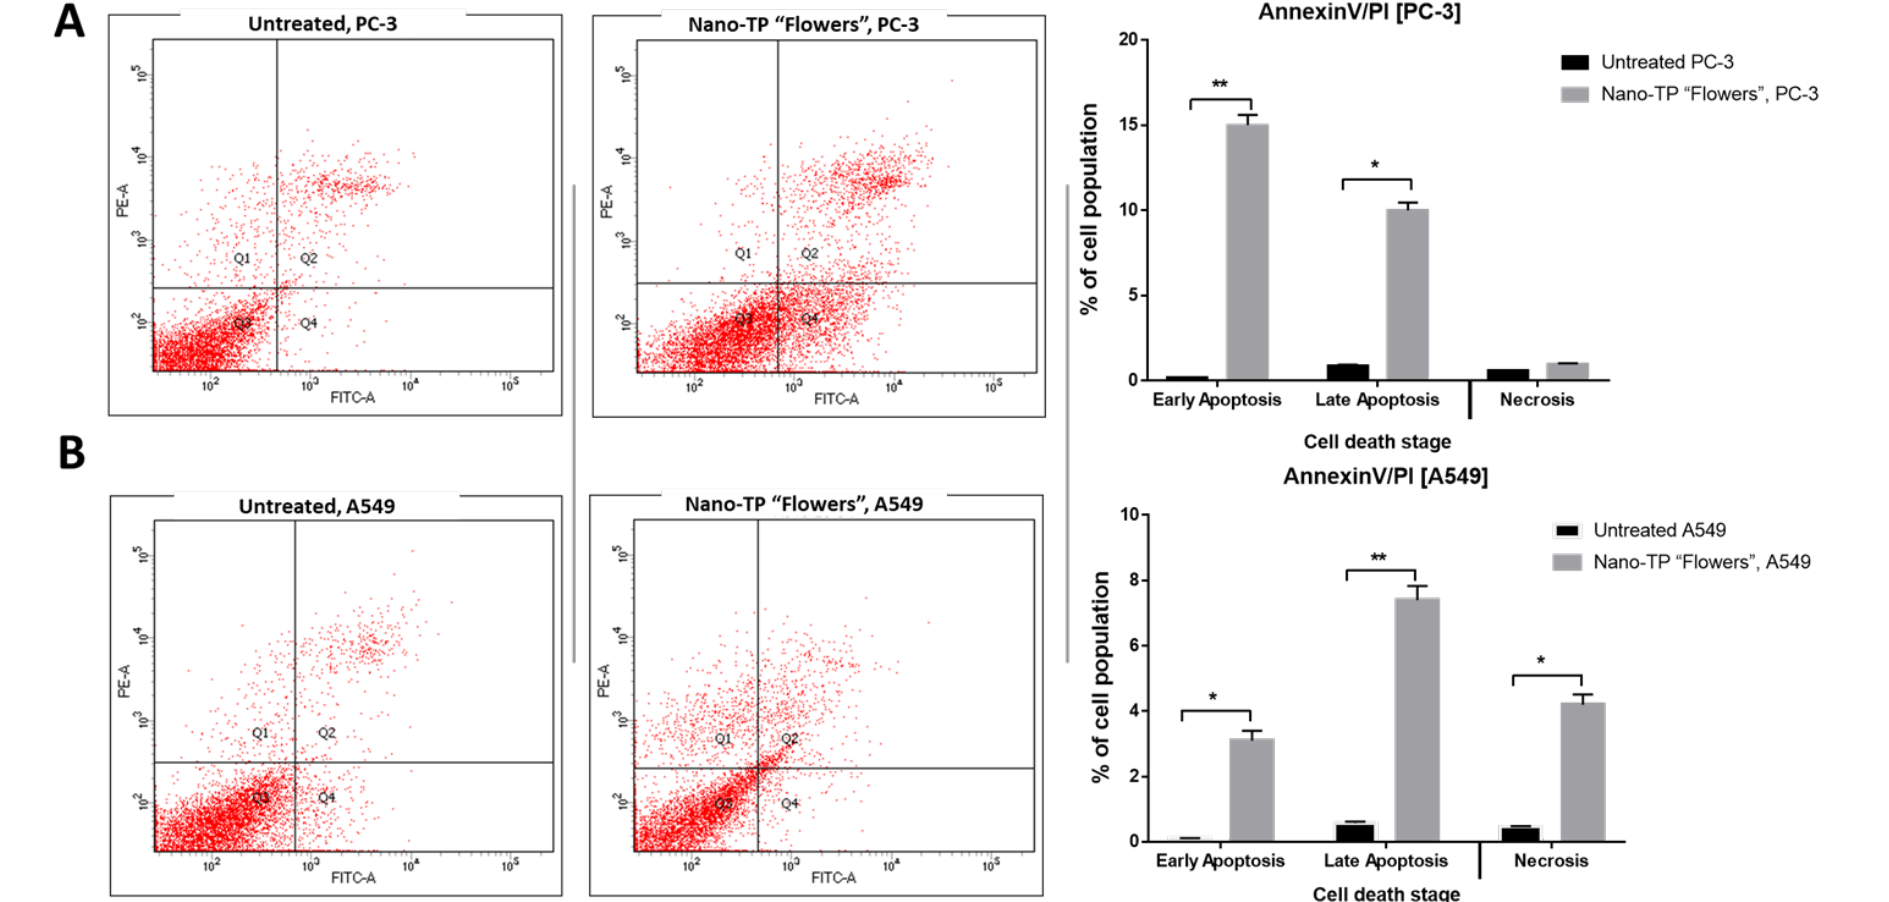
Figure 5. Cytograms and bar representation for apoptosis-necrosis assessment using flow cytometry: ( A ) Annexin V/PI staining of untreated and treated PC-3 cancer cells with Nano-TP/Flowers (IC 50 = 0.94 µM, 48 h); ( B ) Annexin V/PI staining of untreated and treated A549 cancer cells with Nano-TP/Flowers (IC 50 = 0.85 µM, 48 h). Q1: Necrosis, Q2: Late apoptosis, Q4: Early apoptosis. Lower panel. * ( p ≤ 0.05) and ** ( p ≤ 0.001) are significantly different using the unpaired test in GraphPad Prism.